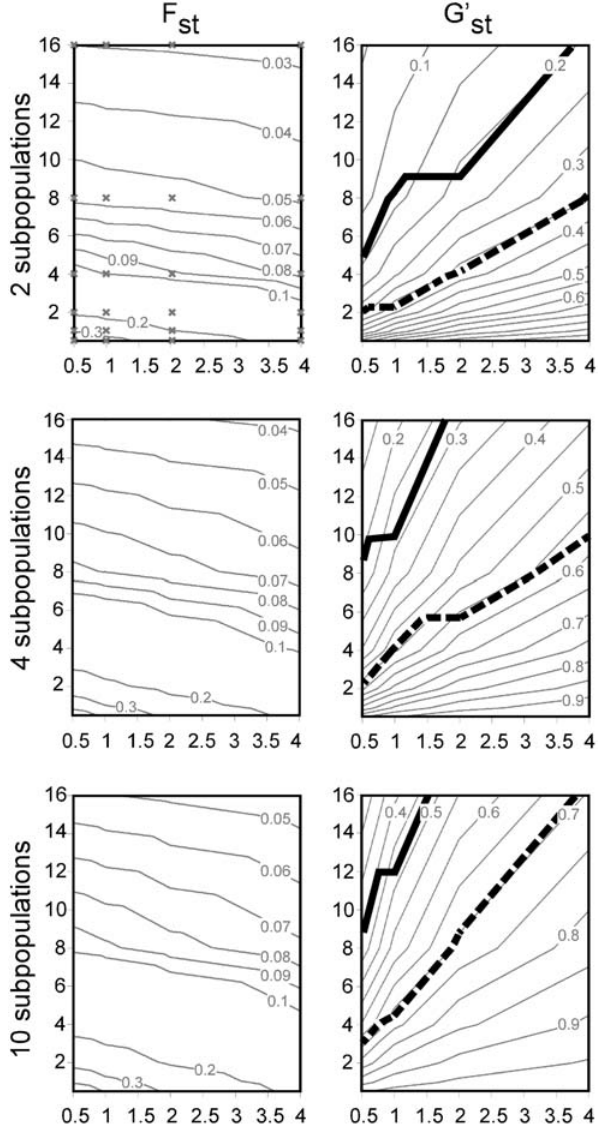
Figure 5. Levels of population subdivision in simulated data sets as viewed by F st and G’ st . X axes=mutation rate ( h ), Y axes =migration rate (M). Contour plots were generated using interpolation between data sets sampled at the X’s plotted in the top left panel. Bold solid lines in G’ st plots represent the 95% success contour for PCO-MC analysis using 100 loci, dashed lines are for K=rv. Below these lines the level of population subdivision was sufficient for correct identification of more than 95% of known